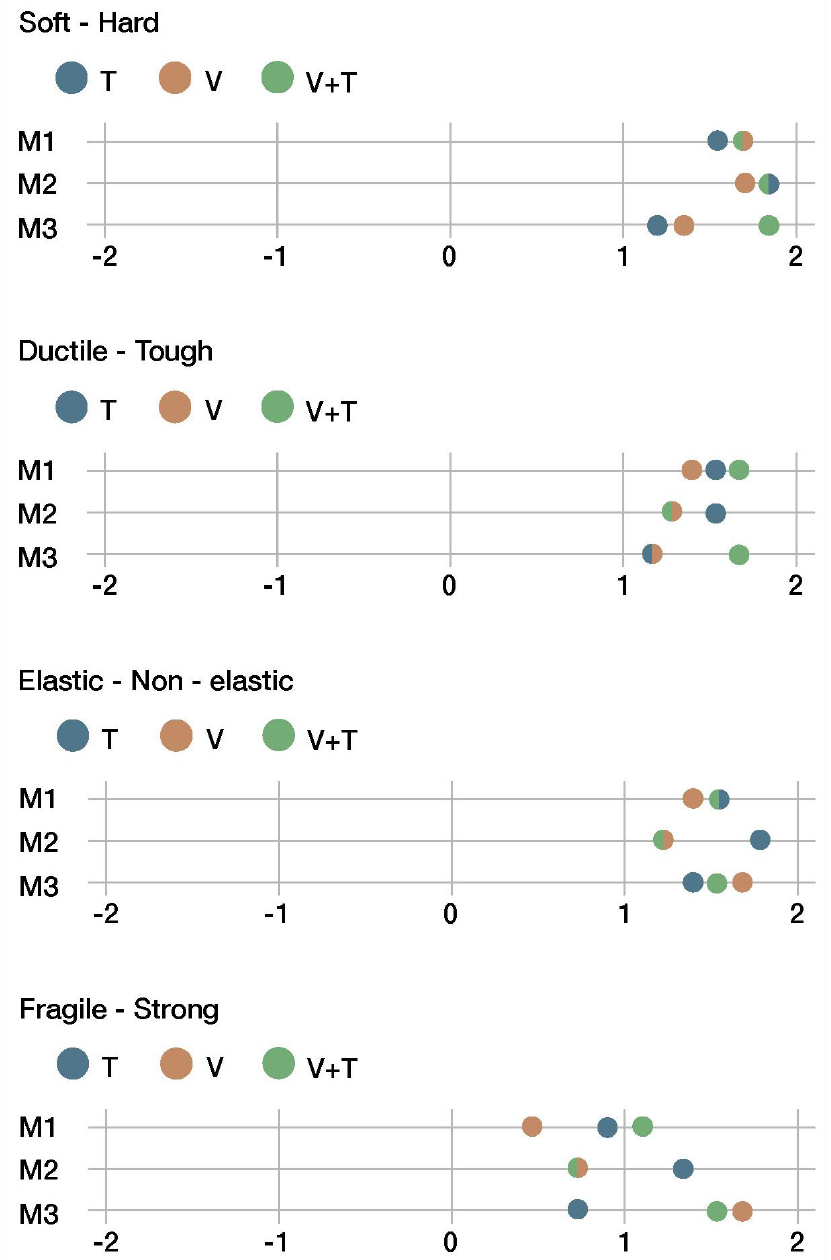
Figure 15. Fourth cluster of sensorial properties.